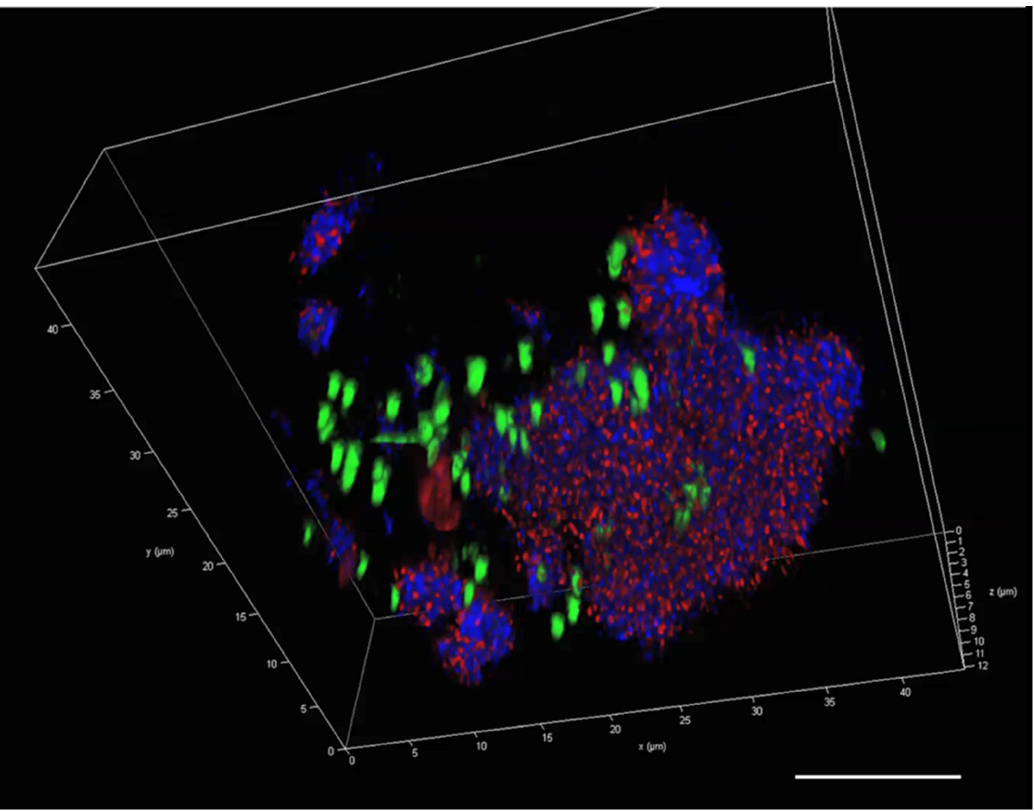
Figure 13. A 3D image of a single particle of P. atlantica particles stained with ConA (blue), TOTO-3 (red) and SYTO 9 (green). Scale bar = 10 µm.